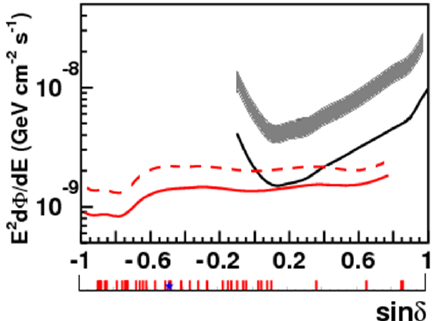
Fig. 2. Sensitivity of the KM3NeT detector to neutrino point sources with an E − 2 spectrum for 1yr of observation, as a function of the source declination. The red lines indicate the flux sensitivity (90% CL; full line) and the discovery flux (5 σ , 50% probability; dashed line). The full black line is the IceCube sensitivity for 1yr; the shaded band indicates the IceCube’s discovery flux (5 σ , 50% probability), spanning a factor 2.5 to 3.5 above the flux sensitivity. The red ticks show the positions of Galactic gamma ray sources, the blue star the position of the Galactic Centre.